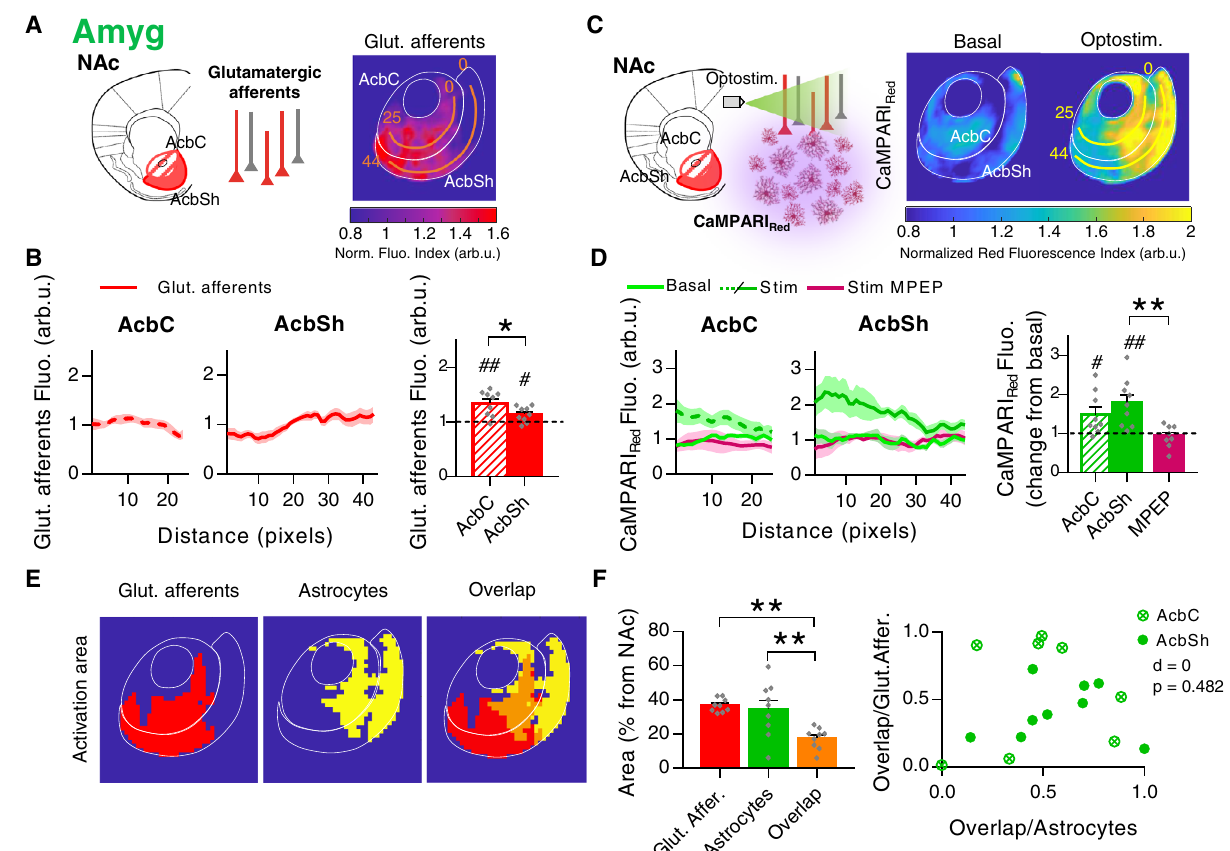
Fig. 5 | Spatial nucleus accumbens (NAc) astrocytic response to basolateral amygdala(Amyg)afferents.A Left,schemeofopsin-transfectedAmygafferentsin the NAc. Right, average PRQ image showing Amyg glutamatergic innervation pat- tern. Orange lines starting from pixel 0 in each subregion were used for quanti fi - cation(pixel=50 µ m 2 ). B Left,glutamateafferents fl uorescence(arb.u.)vsdistance (pixels) quantifying Amyg innervation across orange lines. Right, average gluta- matergic afferents spatial fl uorescence (arb.u.) in the accumbens core (AcbC; sla- shed bar) and accumbens shell (AcbSh; solid bar) (9 slices, 6 mice). One-sample t test, # P =0.017, ## P =0.0021; two-tailed unpaired t test, * P =0.04. C Left, scheme of astrocytic Ca 2+ activity, measured by CaMPARI GFAP red, in response to Amyg afferent ’ soptostimulation.Right,averagePRQimageshowingastrocyticactivation pattern in the NAc in basal and optostimulated conditions. Yellow lines starting frompixel0ineachsubregionwereusedforquanti fi cation(pixel=50 µ m 2 ). D Left, CaMPARI Red fl uorescence (arb.u.) vs distance (pixels) quantifying astrocytic